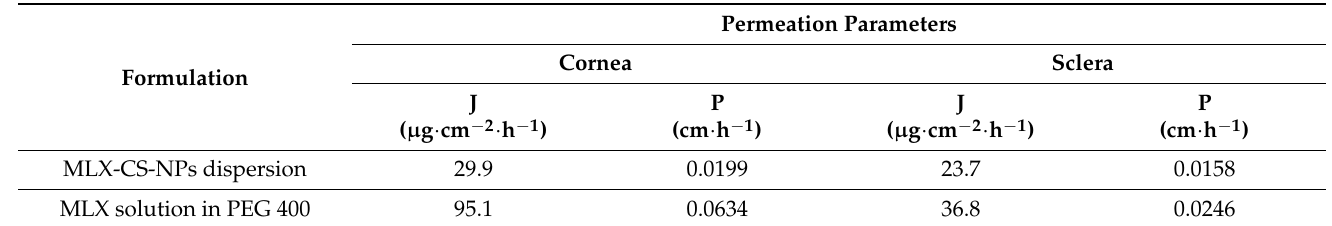
Table 8. Permeation parameters of MLX through cornea and sclera of rabbit eye from MLX-CS-NPs dispersion and MLX solution in PEG 400.